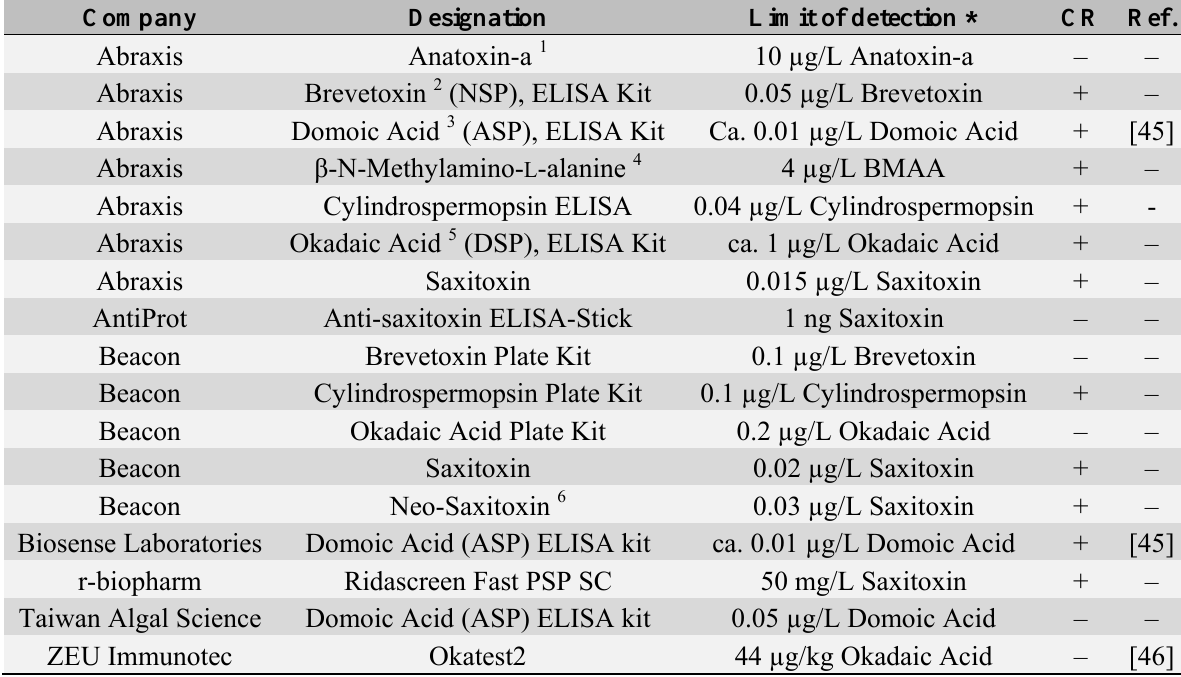
Table 2. Commercial immunoassays against other cyanobacterial toxins and shellfish toxins †